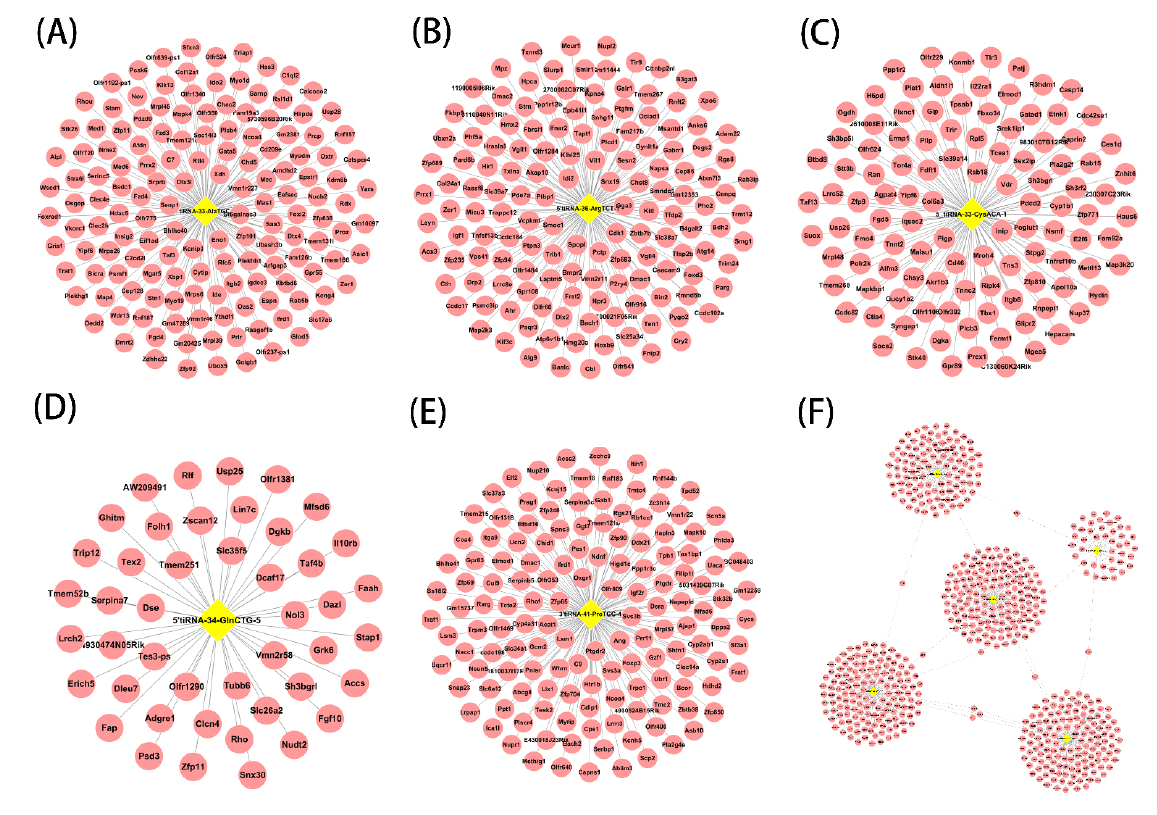
Figure 4. Targets of septic cardiomyopathy-related tsRNAs. ( A – F ) The targets of 5 (cid:48) tiRNA-33-AlaTGC- 7, 5 (cid:48) tiRNA-36-ArgTCT-1, 5 (cid:48) tiRNA-33-CysACA-1, 5 (cid:48) tiRNA-34-GlnCTG-5 and 3 (cid:48) tiRNA-41-ProTGG-4 are shown. tiRNA: tRNA halves; tsRNA: tRNA-derived small RNA.